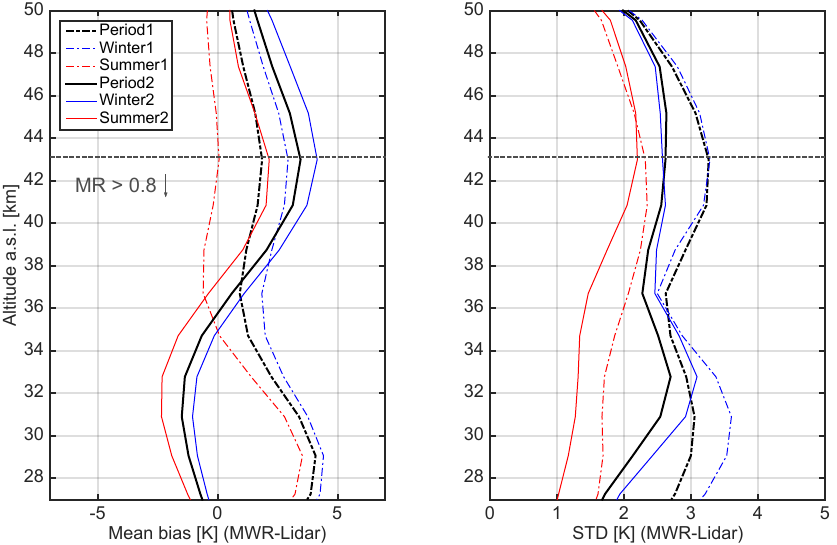
Figure 13. Mean temperature deviation between TEMPERA and lidar. A total of 192 profiles were compared (Period 1: 117 profiles, dashed lines; Period 2: 75 profiles, solid lines). The mean bias and the standard deviations for each period are represented by black lines. The winter season is indicated by blue lines while the summer is indicated by red lines (Winter1: 73 profiles; Summer1: 44 profiles; Winter2: 49 profiles Summer2: